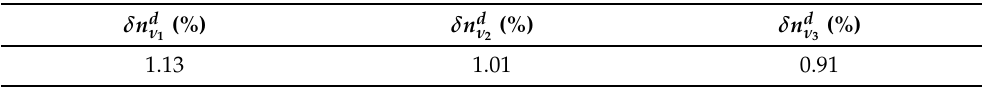
Table 7. Deviation of relic neutrino number density including non-thermal distortions during neutrino decoupling from the case when neutrinos decoupled instantaneously and all e ± -pairs annihilated into